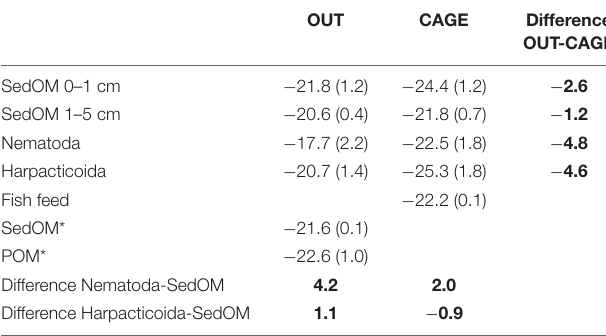
TABLE 2 | δ 13 C ( ± SD) of sedimentary organic matter (SedOM) from different layers, of water column particulate organic matter (POM), of Nematoda and Harpacticoida, and the difference (bold) between OUT vs. CAGE and SedOM vs. fauna. OUT CAGE